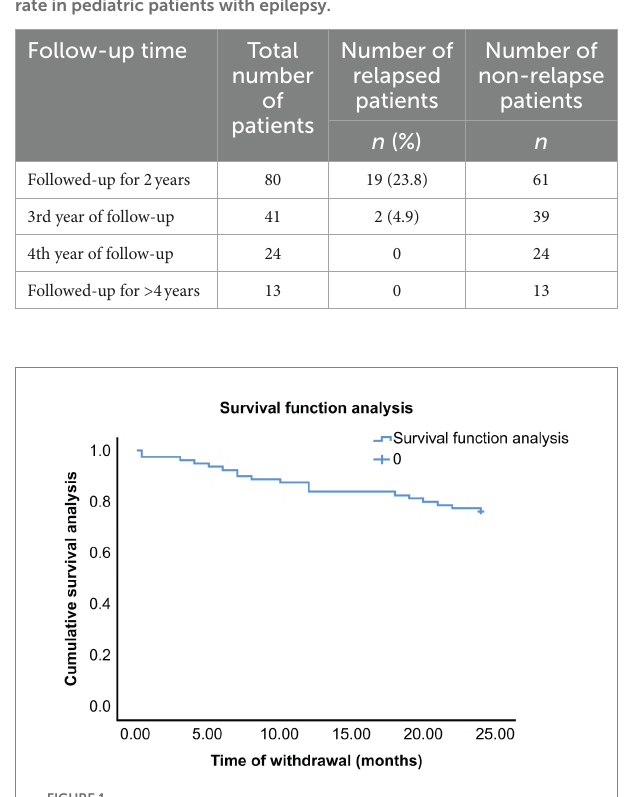
FIGURE 1 Kaplan–Meir survival curve relationship between the time of drug withdrawal and nonepilepsy recurrence rate in all pediatric patients. Zero represents the time of drug withdrawal. The abscissa of the curve represents the time after drug withdrawal, whereas the ordinate represents the proportion of the total number of patients without